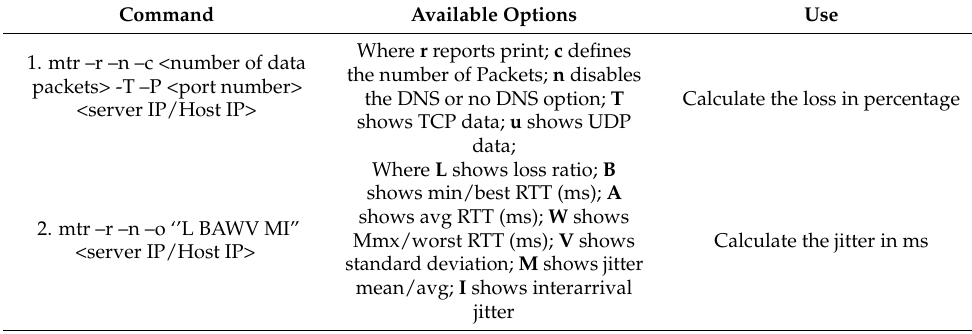
Table 5. MTR data traffic generation to measure the loss and jitter of networks [35].